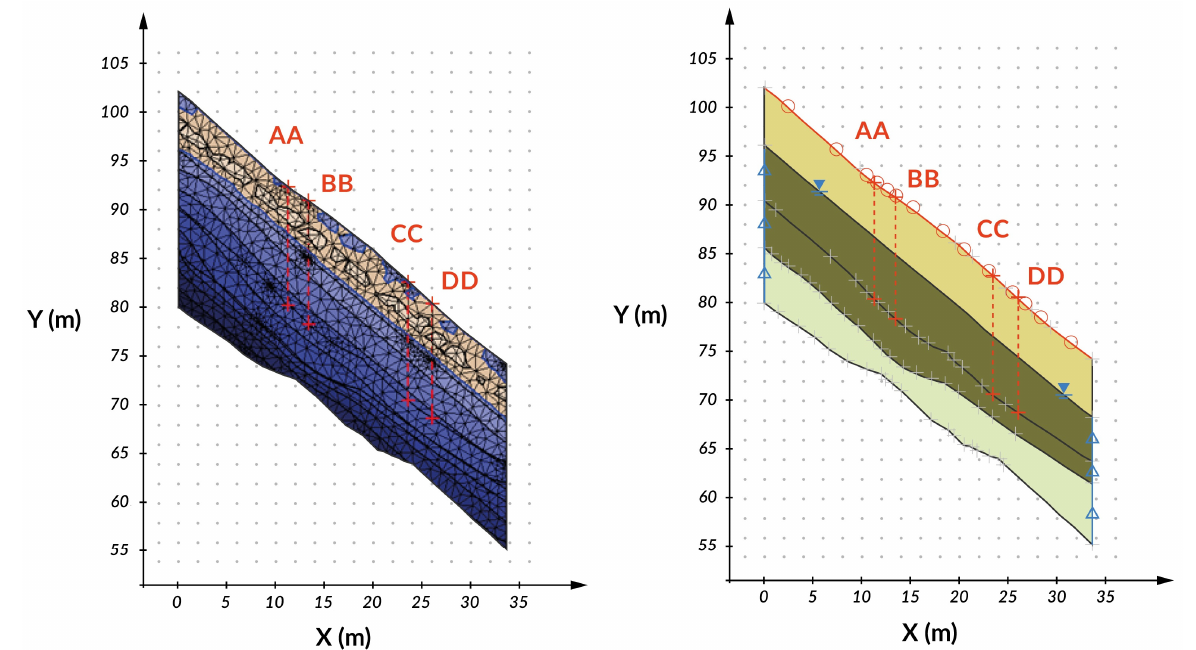
Figure 2. Model geometry, boundary conditions for infiltration process, finite element mesh and pore water control section locations (AA, BB, CC and DD).